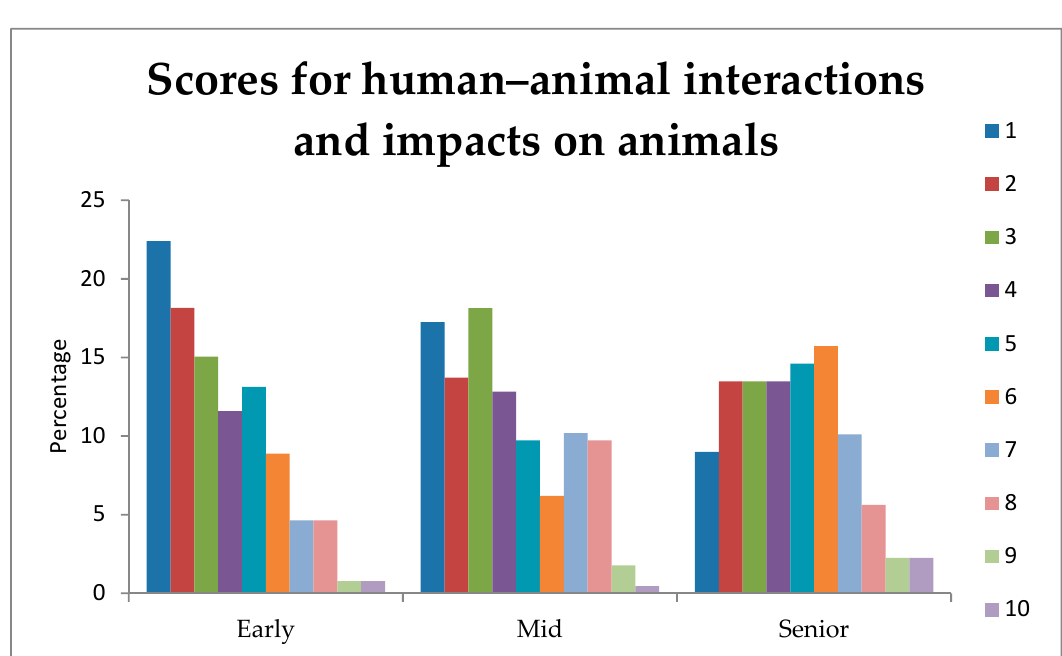
Figure 2. Percentage of students from the Early, Mid, and Senior stages-of-study rating (1 = extremely